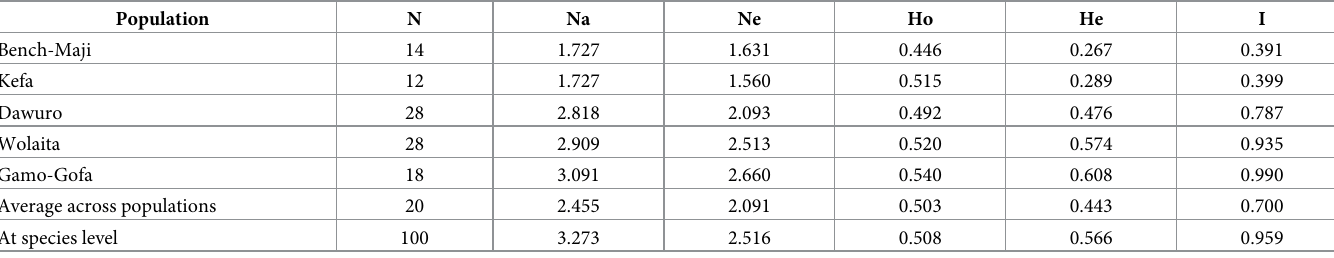
Table 4. Genetic diversity within